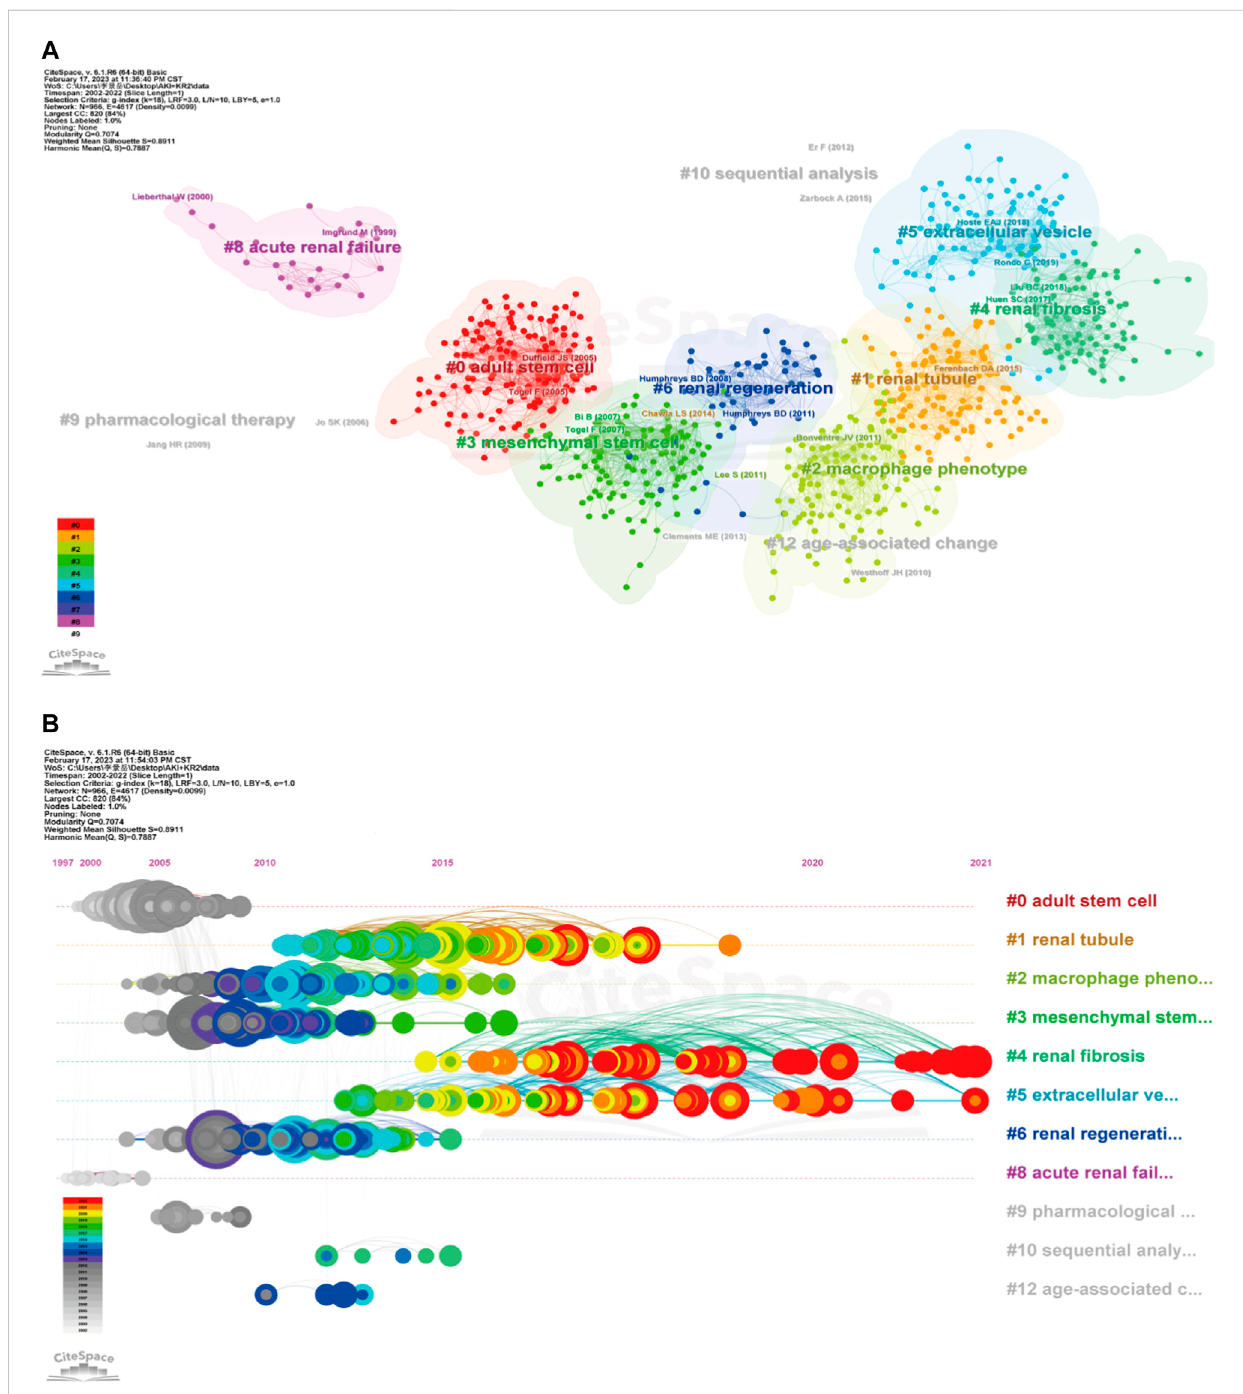
FIGURE 6 Cluster diagram of co-cited references using keywords as label source (A) , and timeline view of co-cited references via title words (B) were visualized through CiteSpace.